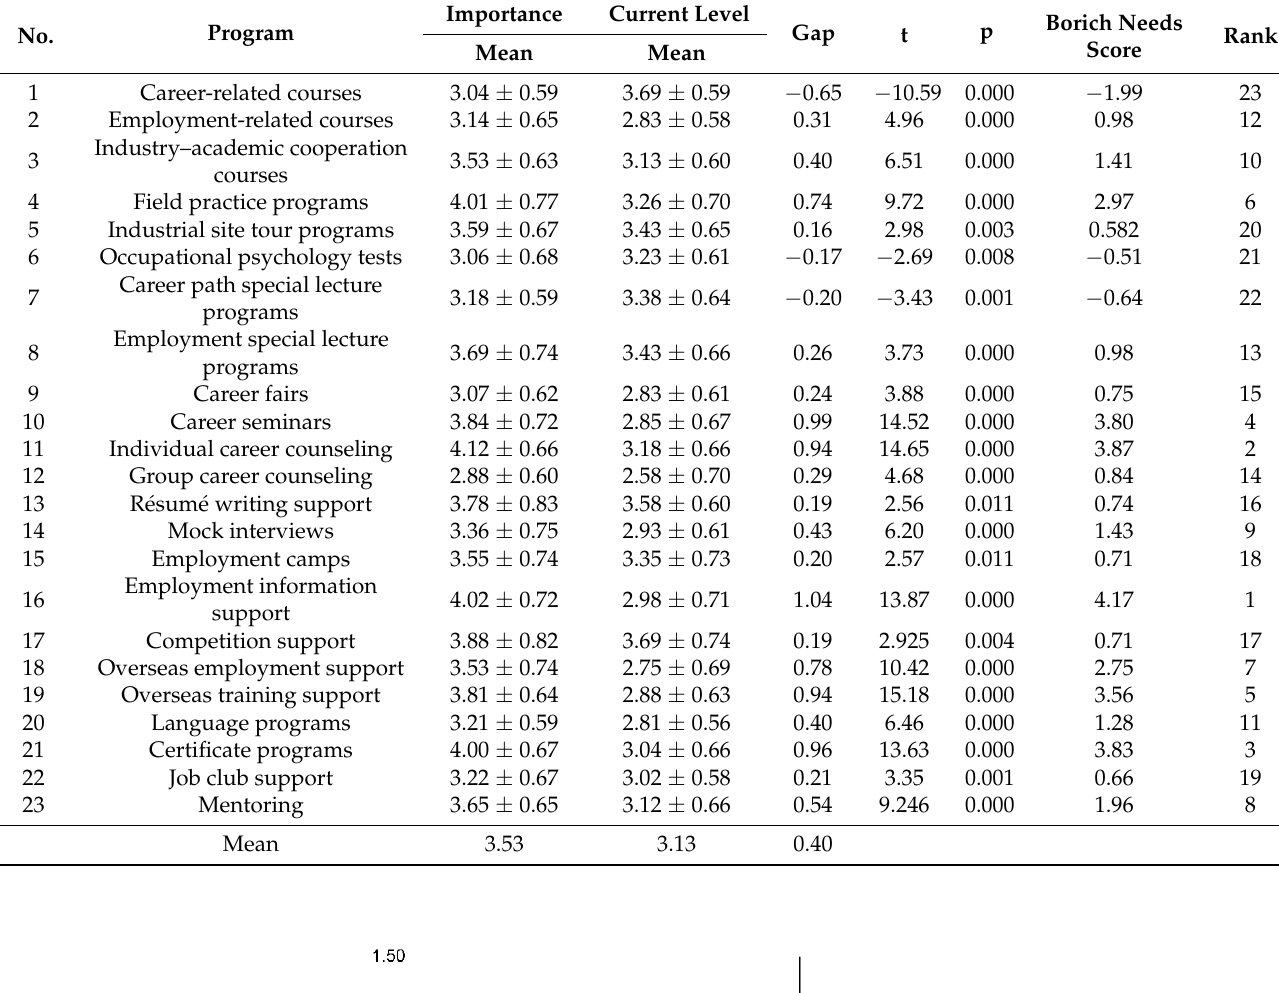
Table 2. Results of paired t-test analysis and Borich needs analysis for 2-year university students.